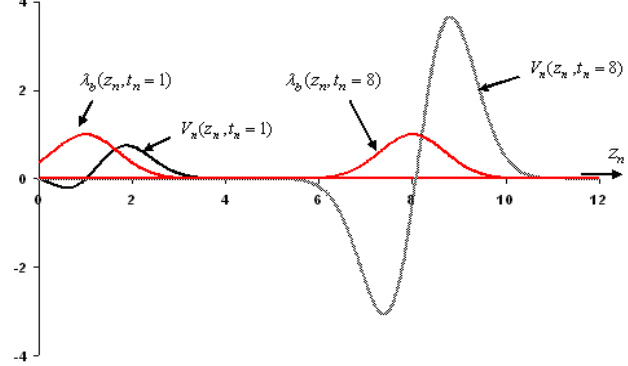
FIG. 24. (Color) Snapshots of the beam loading voltage V induced on the helix by a Gaussian shaped ion beam pulse moving at a constant velocity v normalized as V and time is z beam line charge density is (cid:5)